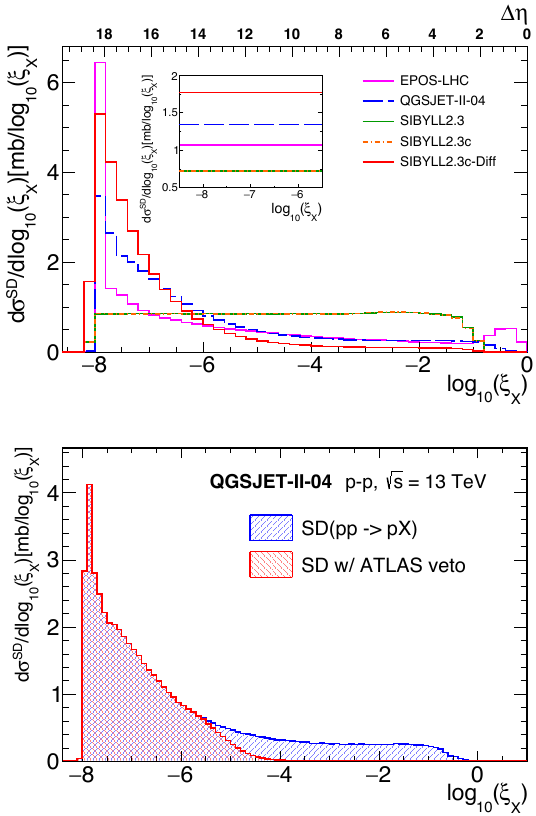
pX ; blue) cross section as a function Figure 2. The SD ( pp → of log 10 ξ X predicted by MC simulation models. There is a large discrepancy among models, especially in the low-mass di ff rac- tion region (top pad). On the bottom pad, the survived events are mostly low-mass di ff raction by applying the ATLAS-veto selec- tion (red) compare to the inclusive SD cross section predicted by QGSJET-II-04 (blue) [3].